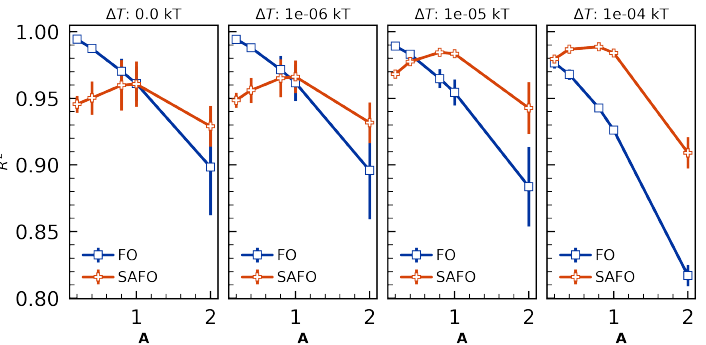
Figure 8. Quality of fit for first-order (FO) and self-accelerated first-order (SAFO) reaction models as a function of ∆ T rxn and A = n B validate FO kinetics are most accurate for ∆ T = 0, and that SAFO τ B kinetics best fit the concentration profiles when ∆ T = 1 e − 4. Error bars show standard error in R 2 value averaged across cure temperatures T = 0.5,1.0,2.0,4.0,6.0 kT